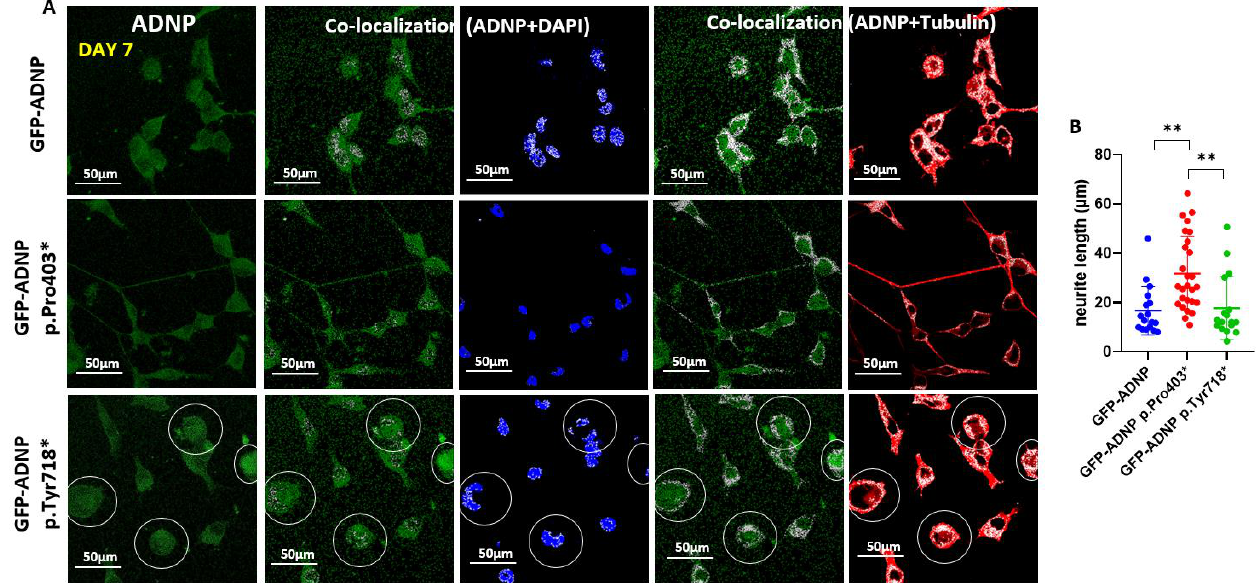
Figure 5. Close inspection of tubulin and DAPI in differentiated neuronal-like cells (day 7 in culture) indicates increased neurite length upon GFP-ADNP p.Pro403* mutant expression. ( A ) Images show four-fold enlarged co-localization regions of Figure 4A,B. Cells with diffusely distributed stained proteins, identified by diffuse nuclear/cytoplasmic co-localization, are circled. ( B ) Neurite lengths were measured using Fiji-ImageJ image processing software [31]. The longest neurites were measured in GFP-ADNP p.Pro403*-expressing cells, ** p < 0.01.